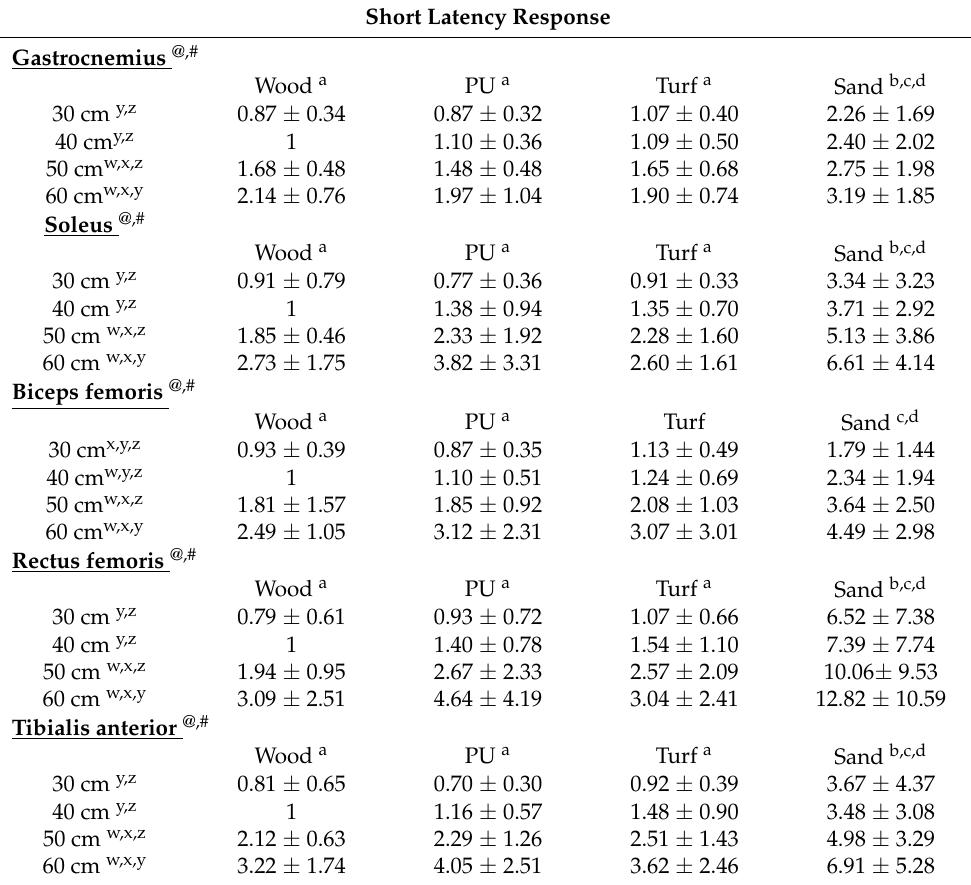
Table 2. Comparisons of normalized EMG 30–60 ms after ground